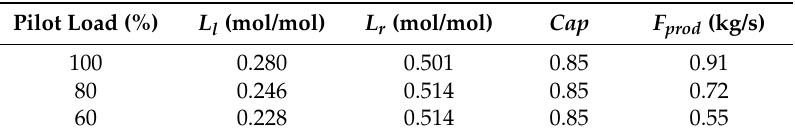
Table 6. Simulated pilot plant values for the process variables, lean CO 2 loading L l , rich CO 2 loading L r , CO 2 capture ratio Cap and CO 2 product flow rate, at three different operating points of the plant, corresponding to 100%, 80% and 60% of flue gas mass flow rate capacity of the pilot plant. With Cap = 0.85 and T str = 120.9 ◦ C for all